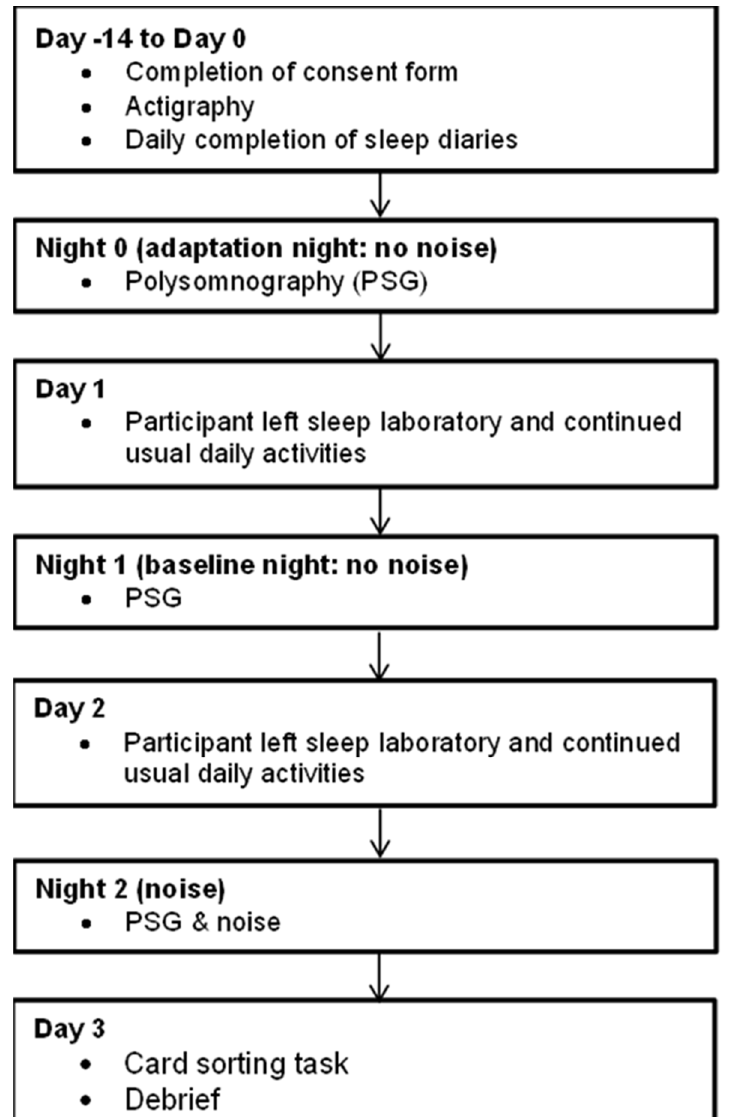
Figure 2. Study procedure (PSG: polysomnography).